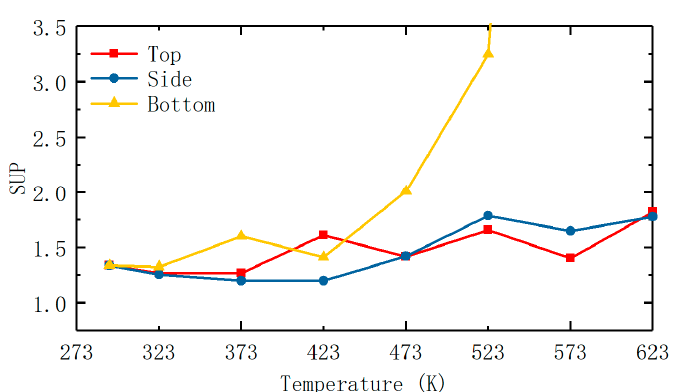
Figure 8. Uniformity of different heating temperatures of the external mixing nozzles at different heating modes.